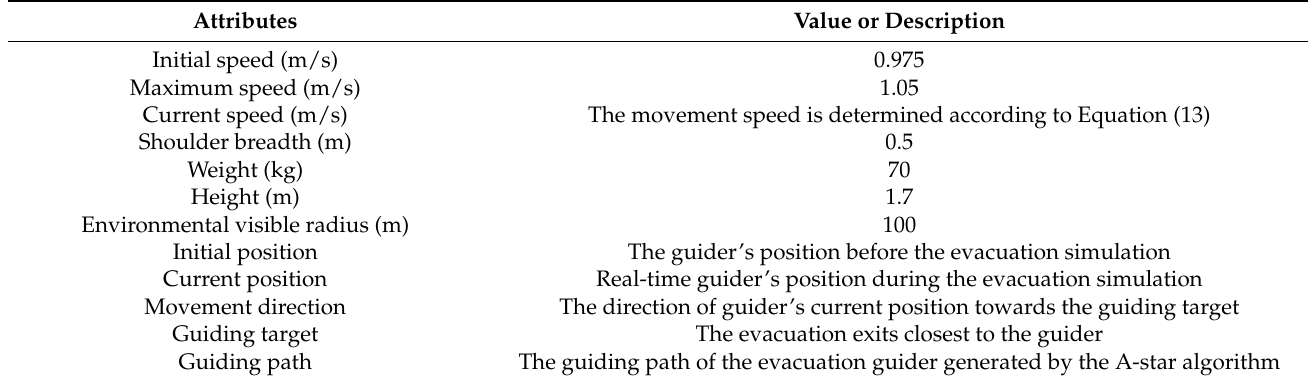
Table 1. Attributes of the evacuation guider agent.